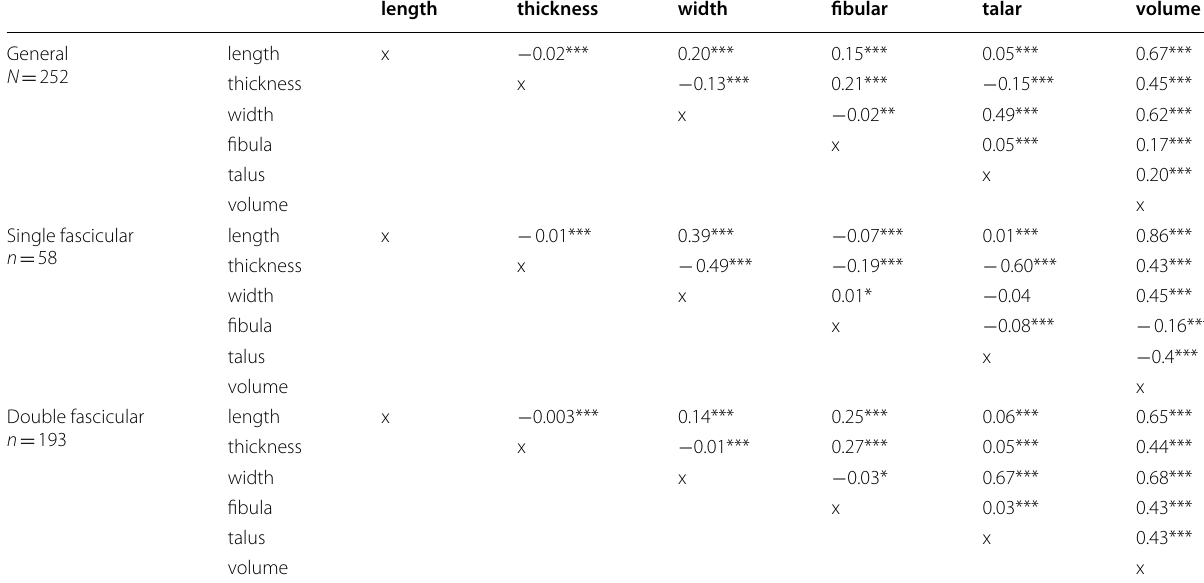
Table 3 Correlation of the anterior talofibular ligament’s dimensions